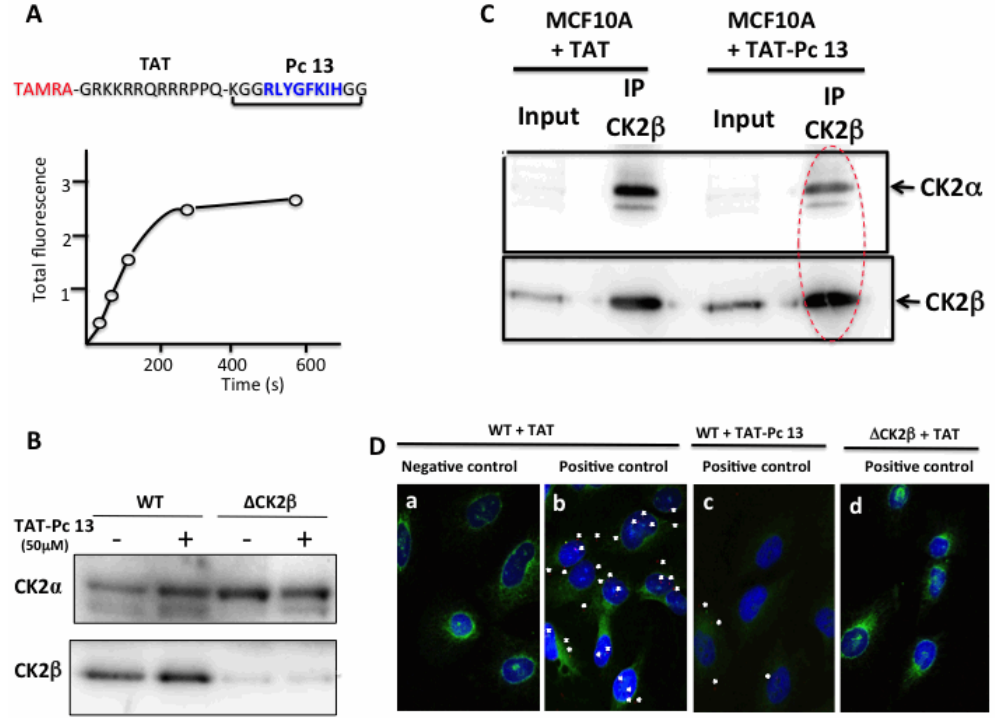
Figure 7. Uptake and cellular effects of TAT-Pc 13. ( A ) kinetic of TAMRA-TAT-Pc 13 uptake in MCF-10A cells; ( B ) WT or CK2 β -depleted MCF-10A cells were incubated with 50 µ M TAT or TAT-Pc 13 for 8 h and the expression of CK2 subunits was evaluated by Western blot; ( C ) anti-CK2 β immunoprecipitates were prepared from WT MCF-10A cells incubated with 50 µ M TAT or TAT-Pc 13 for 2 h. Presence of CK2 subunits in the corresponding immunoprecipitates was determined by Western blot; ( D ) in situ proximity ligation images of MCF-10A cells incubated with 50 µ M TAT (a,b,d) or TAT-Pc 13 (c) for 6 h. WT cells were incubated with CK2 α antibody alone (a) or CK2 α and CK2 β antibodies (b,c). CK2 β -depleted cells ( ∆ CK2 β ) were incubated with 50 µ M TAT and then with CK2 α and CK2 β antibodies (d). Actin staining in green, scale bar 10 µ